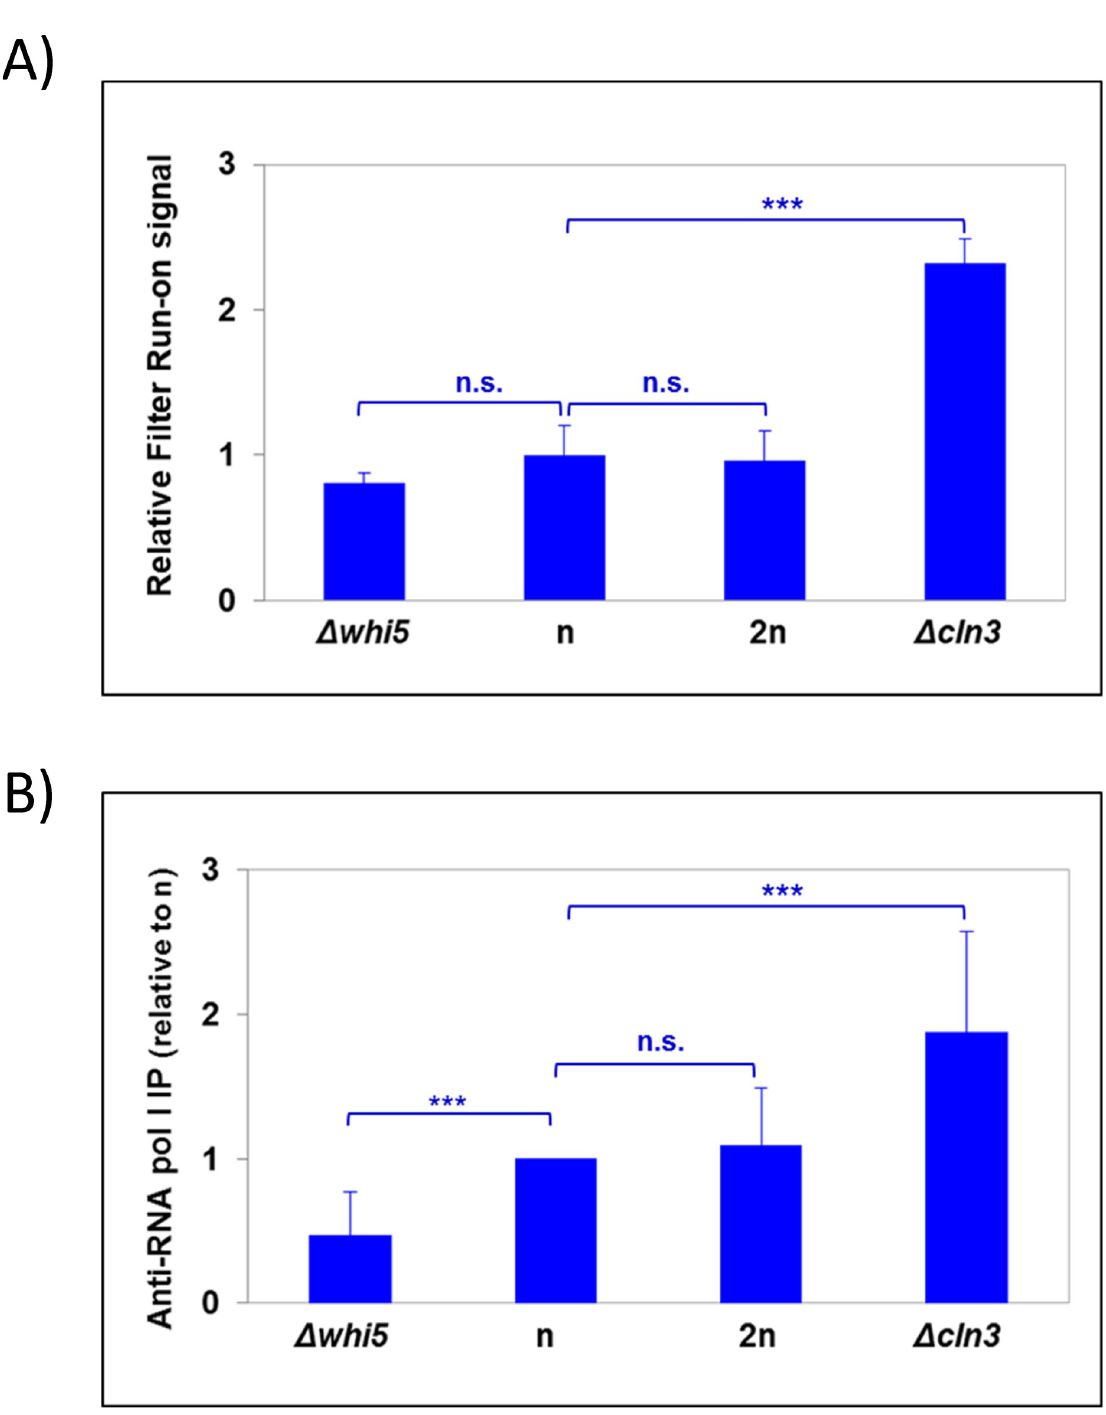
Fig 1. The RNA pol I nTR per genome copy changes in haploid cell size mutants. The nTR was determined in a series of haploid yeast strains with different cell volumes (see S1 Table) and a diploid (2n) control strain for the total RNA pol I nTR by filter run-on (A) that measures the total nTR (I+II+III), or by chromatin immunoprecipitation of its second largest subunit (A135) (B) that measures only RNA pol I nTR. In both cases, the nTR is given per genome copy. A t-test was used for statistical significance: n.s (not significant), ��� : p- value <